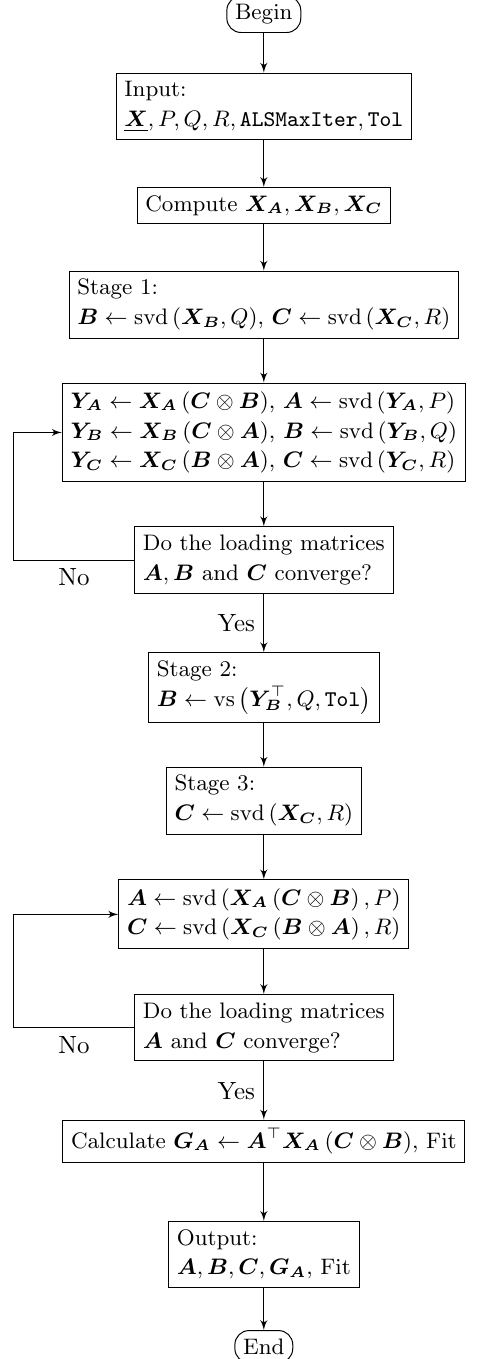
Figure 1. Flowchart of the DisjointTuckerALS algorithm that computes a single disjoint orthogonal matrix (in this case, the matrix B